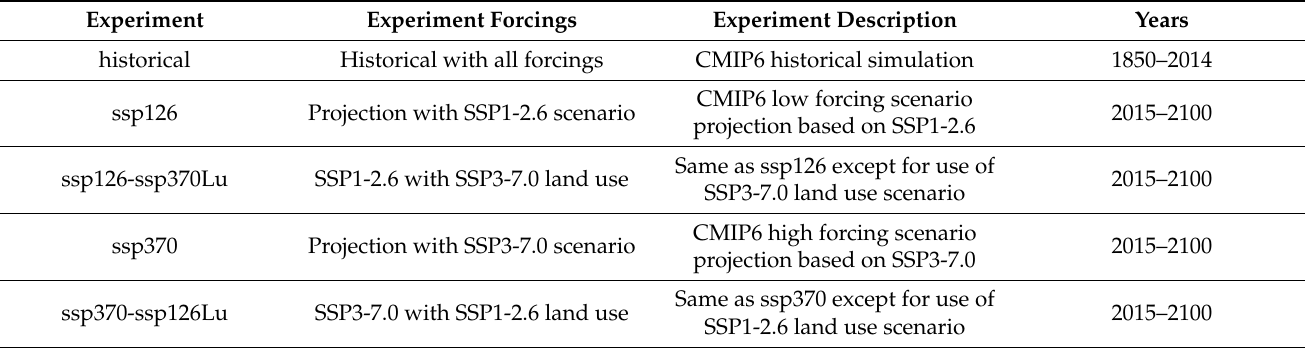
Table 1. Summary of CMIP6 experiments used in this